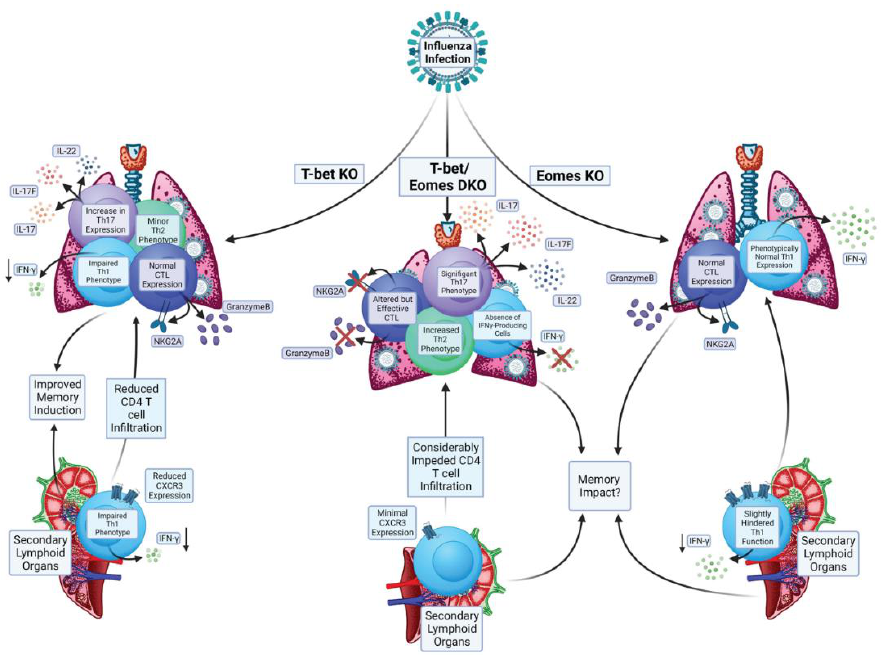
Figure 3. Impacts of Eomes and its paralog T-bet on CD4 T cell responses during Influenza A Virus infection.